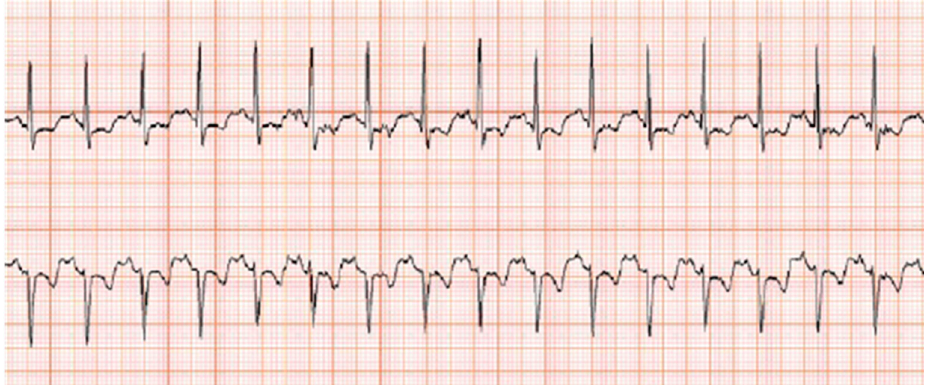
Figure 2. Electrocardiogram obtained when the patient complained of transient chest discomfort. ST depression and negative T waves were recorded in leads II, III, and aVF.